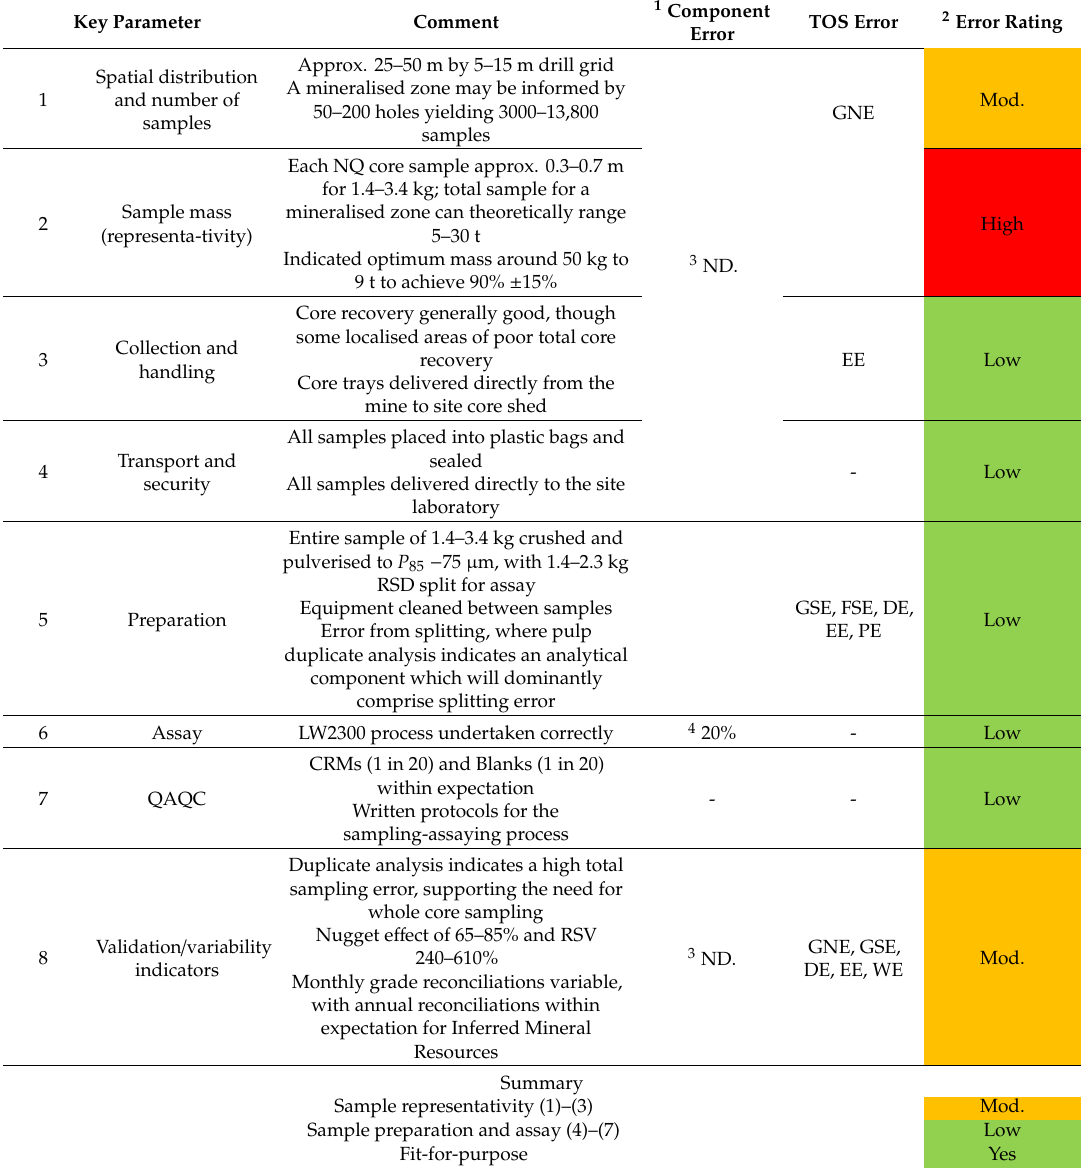
Table 14. Risk review of the Ballarat core sampling programme (Table 12) used during production for resource